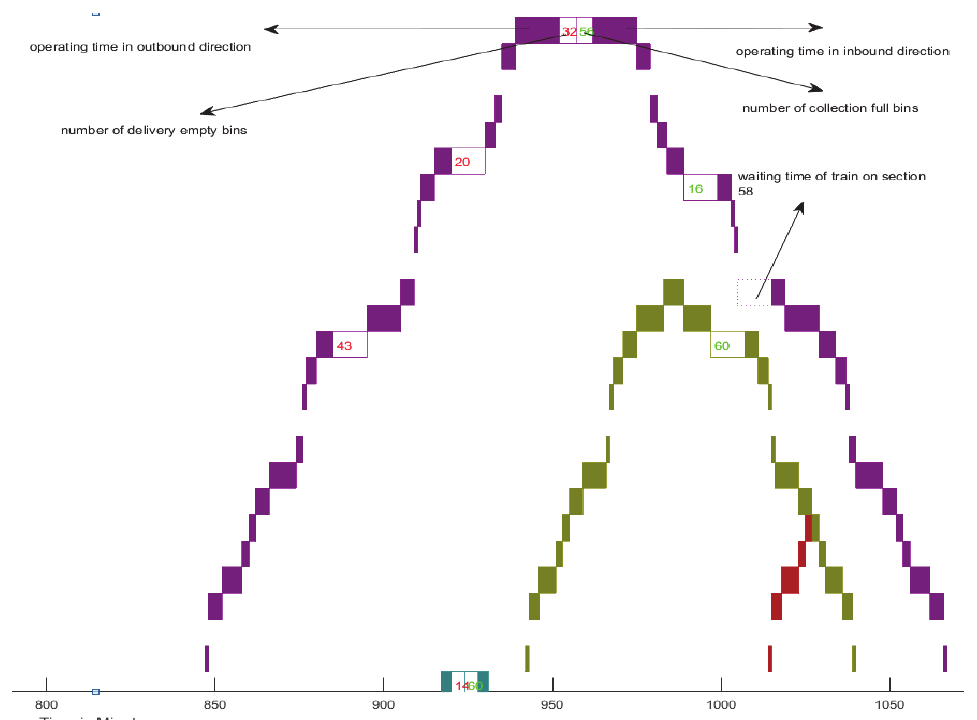
Fig. 13. Close up of train scheduling showing delivery and collection